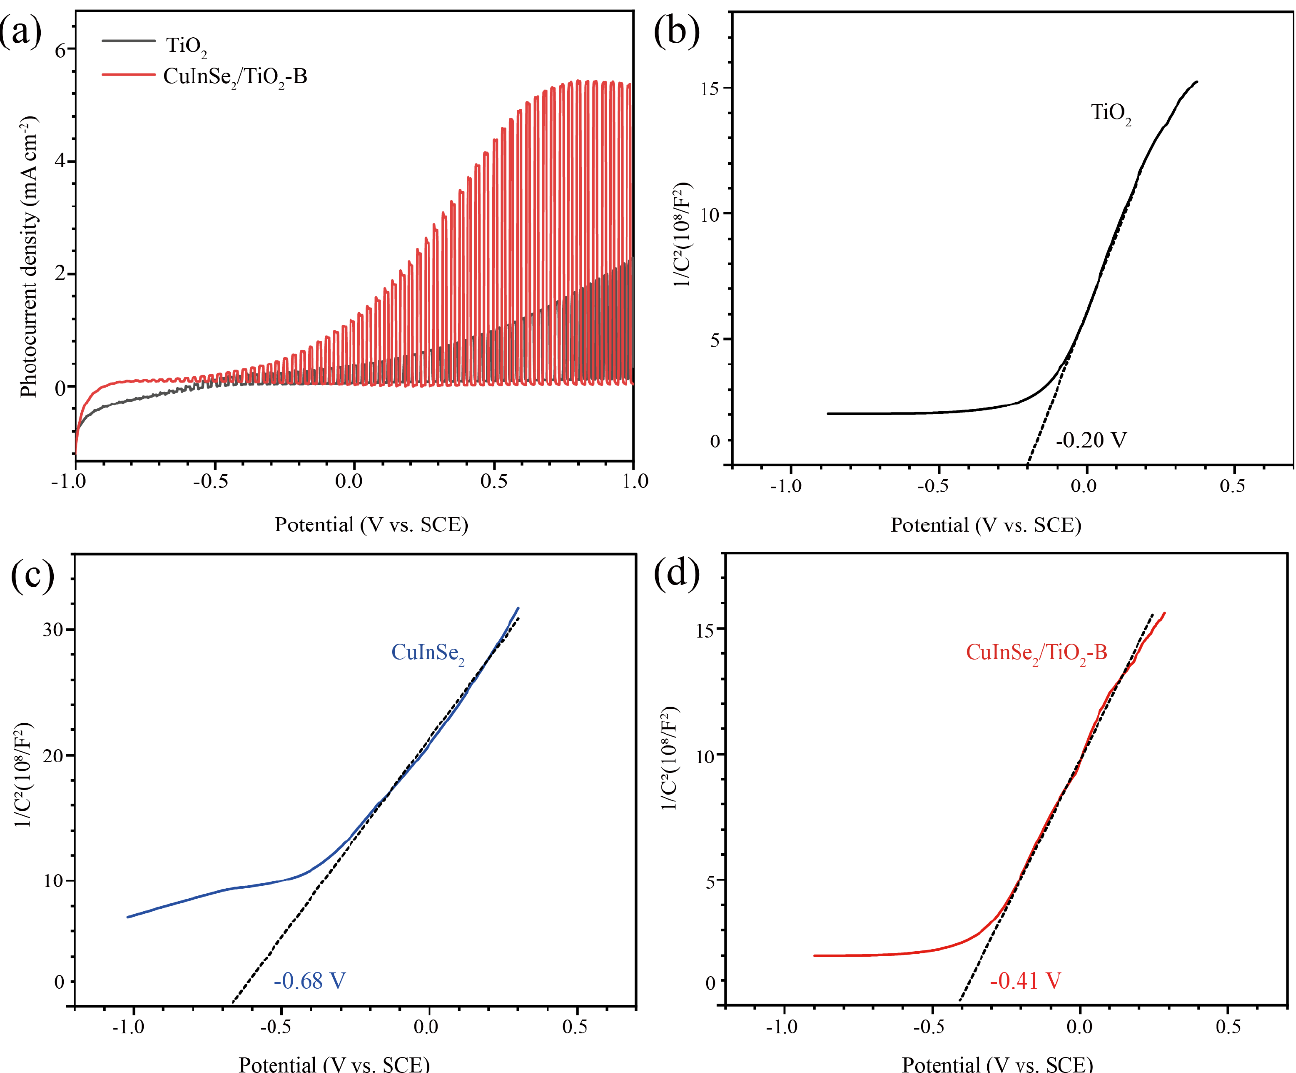
Figure 8. ( a ) I–V curves of the prepared TiO 2 and CuInSe 2 /TiO 2 ‐ B; ( b – d ) M–S plots of TiO 2 , CuInSe 2 and CuInSe 2 /TiO 2 ‐ B.